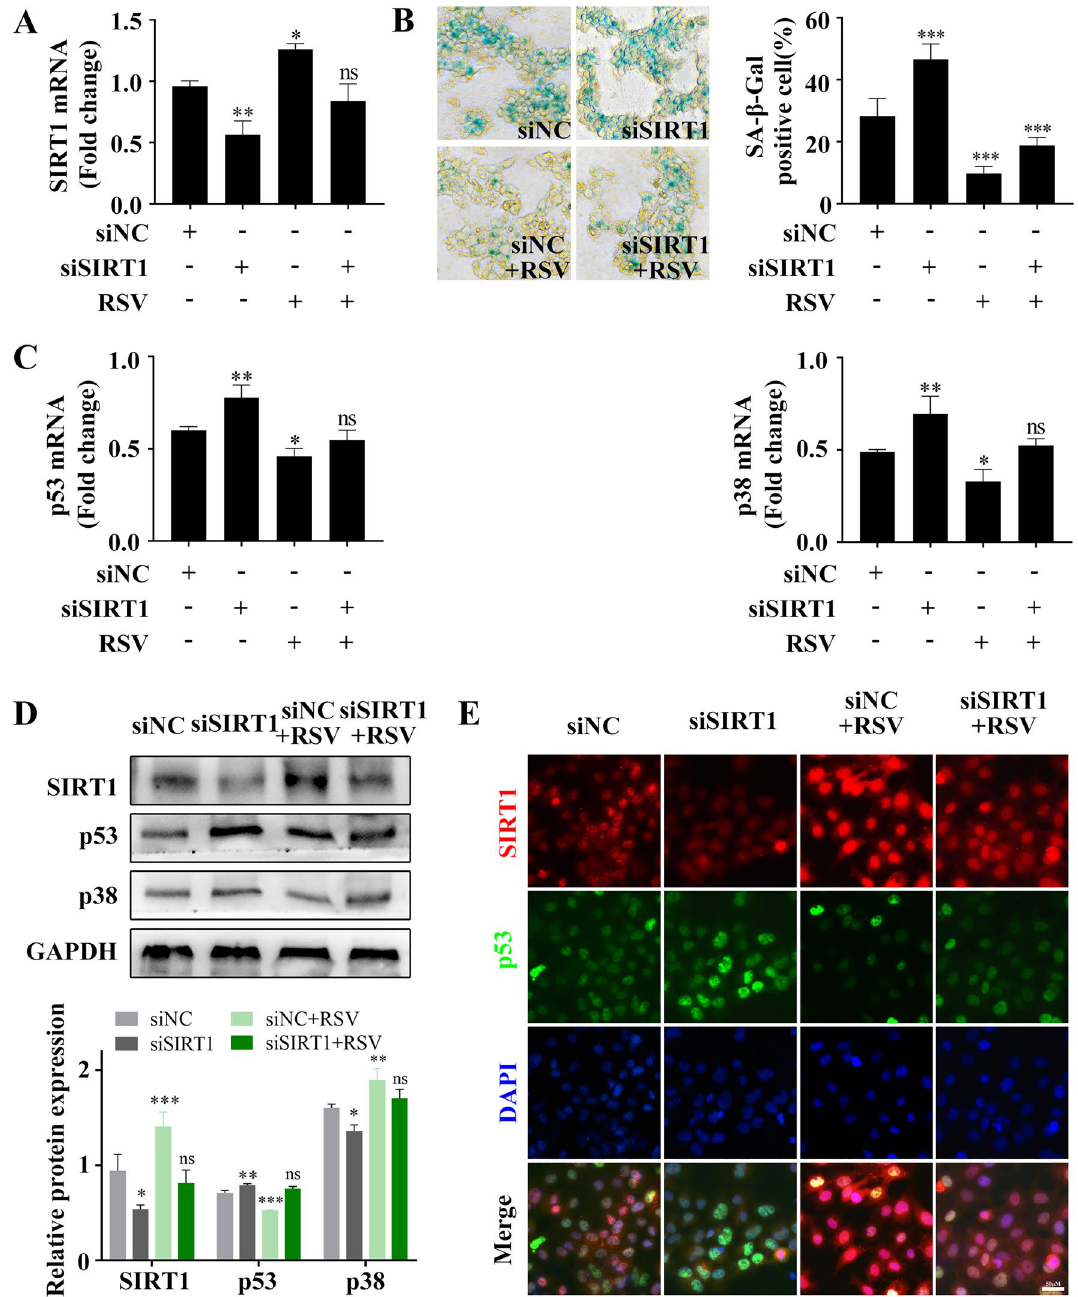
SaβG staining in parallel Ishikawa cell cultures ( B ). qPCR analysis of p53 and p38 mRNA levels in Ishikawa cells first transfected with siNC or siSIRT1 and then treated with or without RSV for 24 h ( C ). Representative western blot and quantification of senescence-related genes from parallel cell cultures ( D ). p53 and SIRT1 protein levels were examined by immunofluorescence staining ( E ). RSV resveratrol. Scale bars = 50 µm in ( E ). * p < 0.05, ** p < 0.01, *** p <